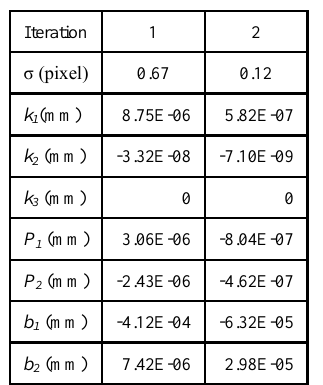
Figure 6. Changes of σ and the corrections of interior orientation parameters of Trial C